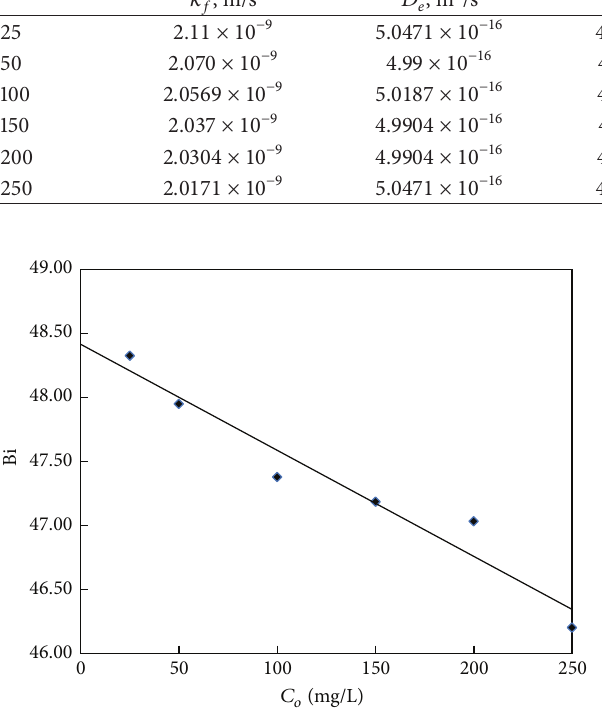
Figure 4: The effect of initial concentration on the Biot number for adsorbent treated with